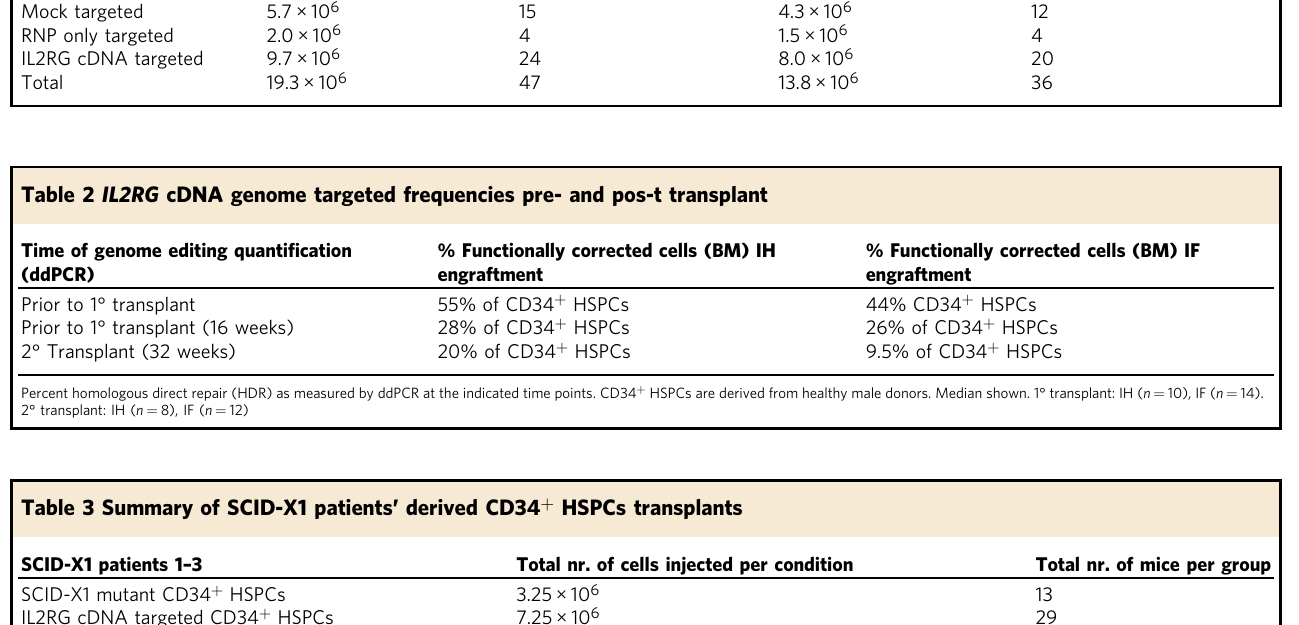
Table 1 Summary of total number of cells and mice injected per condition for primary (1°) and secondary (2°) transplants Genome editing condition transplanted into NSG mice